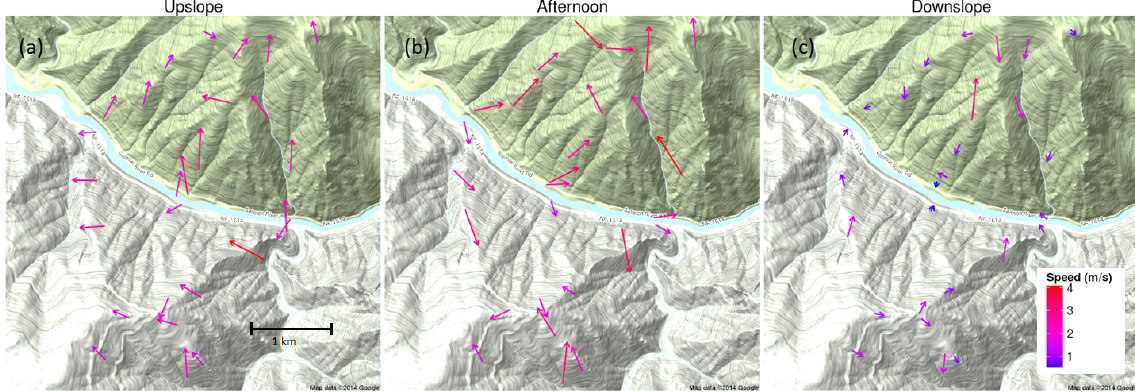
Figure 11. Average flows during (a) upslope (11:00 LT), (b) afternoon (16:00 LT), and (c) downslope (00:00 LT) regimes at the Salmon River Canyon site during periods of weak synoptic flow between July and September 2011. Vectors represent the average hourly flow at a given sensor. Periods of strong synoptic forcing were removed prior to averaging.